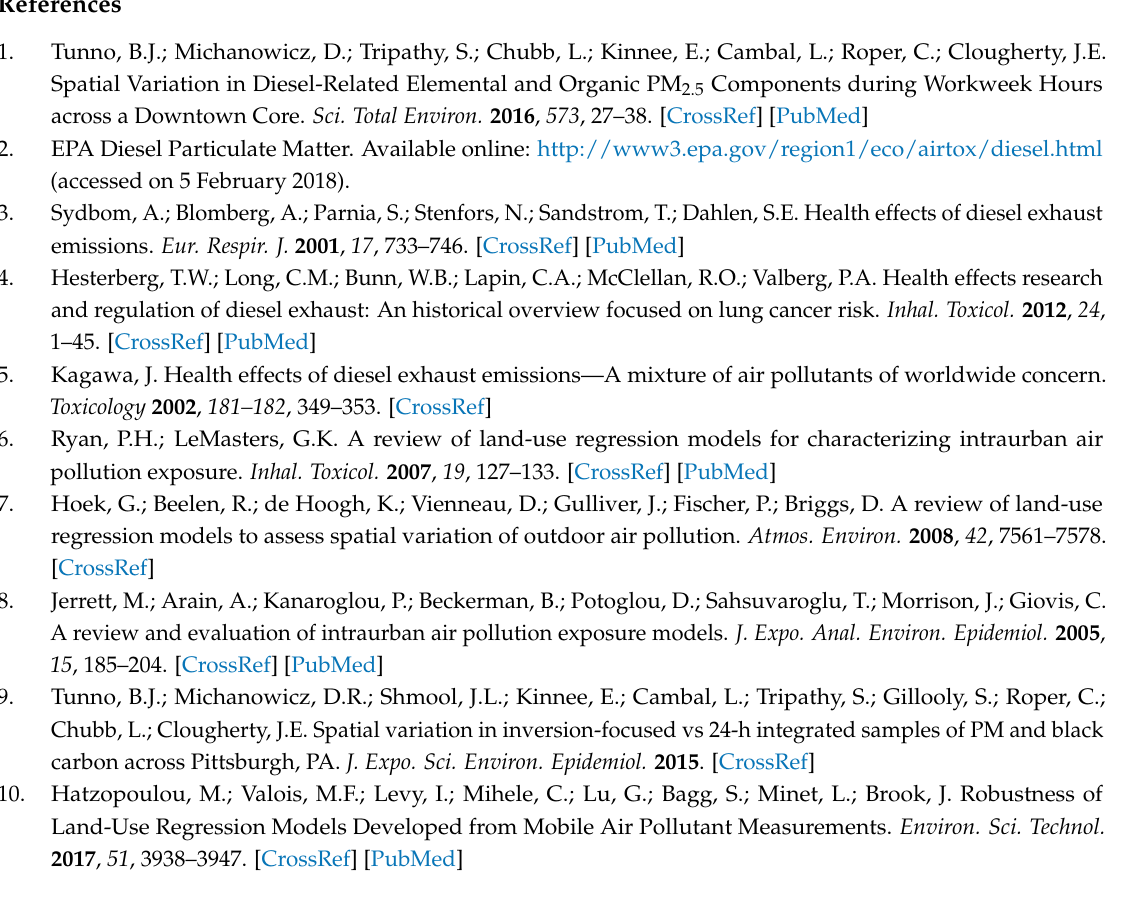
s1, Table S1: Summary and comparison of rush-hour temporally-adjusted pollutant concentrations by winter and summer seasons, Table S2: Summary and comparison of work-week temporally-adjusted pollutant concentrations by winter and summer